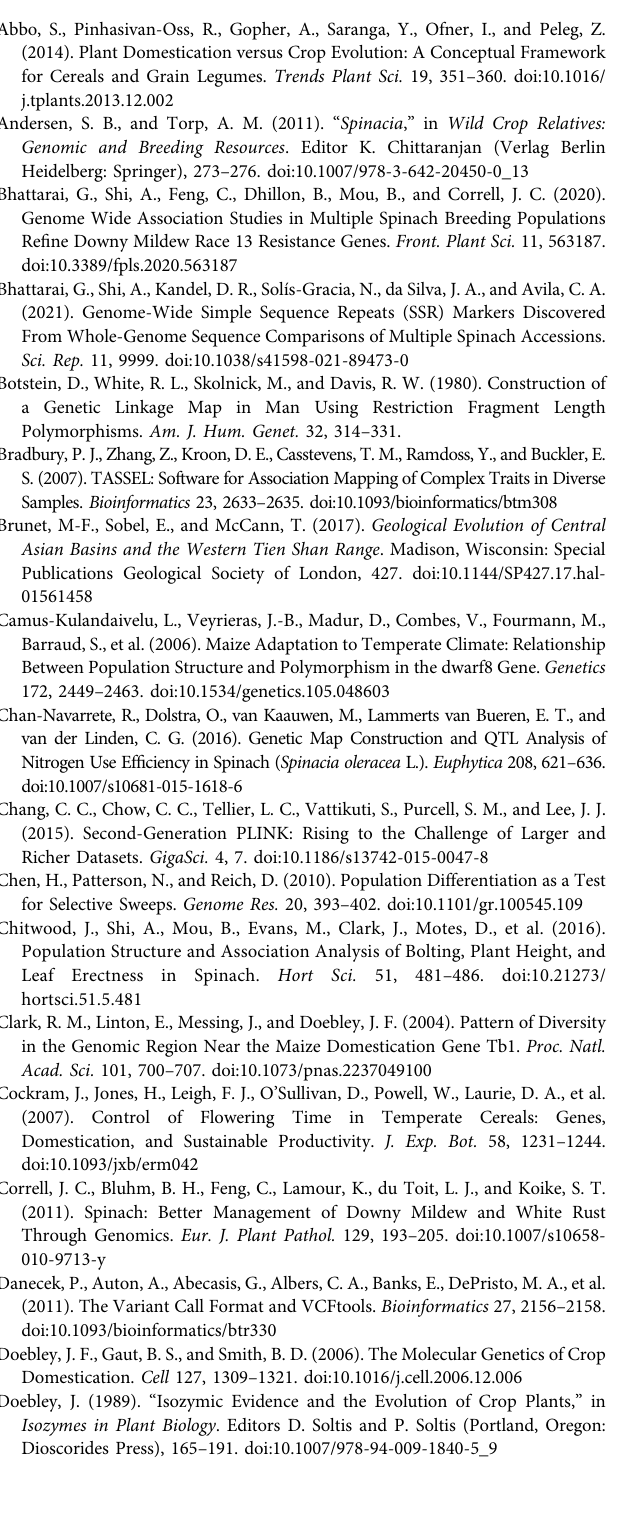
Supplementary Figure 1 | Distribution of the genetic diversity (A) and polymorphic information content (PIC) (B) for 7,065 single nucleotide polymorphisms (SNPs)